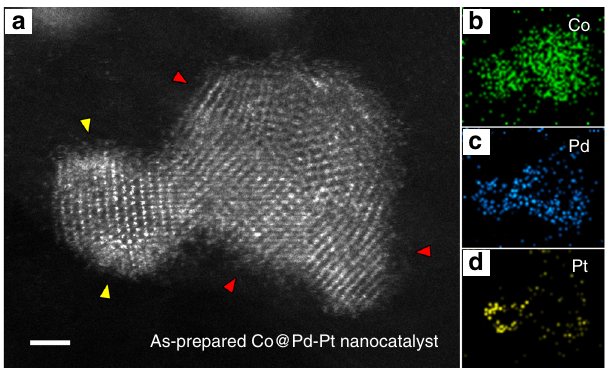
Fig. 1 Scanning transmission electron microscopy (STEM) of Pt-decorated Co-Pd. a Atomic-scale high angle annular dark fi eld-STEM (HAADF-STEM) image of as-prepared Pt-decorated Co-Pd (Co@Pd-Pt) nanocatalyst. Yellow and red arrows indicate the decorated Pt species and the unconformable Pd shell regions, respectively. Scale bar: 1 nm. b – d EDS elemental maps of